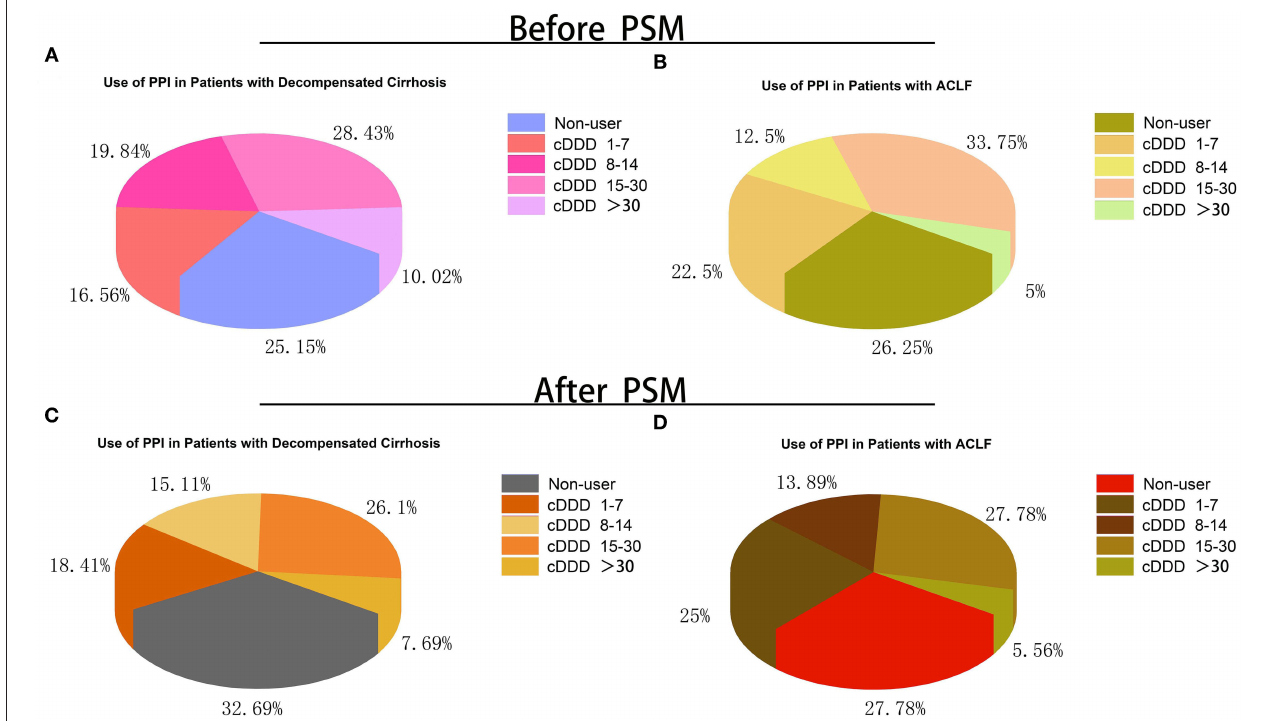
FIGURE 2 | Proportion of patients with different doses and without PPI treatment during hospitalization. (A) Proportion of patients with different doses and without PPI treatment in acute decompensated cirrhosis before PSM; (B) Proportion of patients with different doses and without PPI treatment in ACLF before PSM; (C) Proportion of patients with different doses and without PPI treatment in acute decompensated cirrhosis after PSM; (D) Proportion of patients with different doses and without PPI treatment in ACLF after PSM. cDDD, cumulative defined daily dose; PPI, proton pump inhibitor; ACLF, acute-on-chronic liver failure; PSM, propensity score matching.